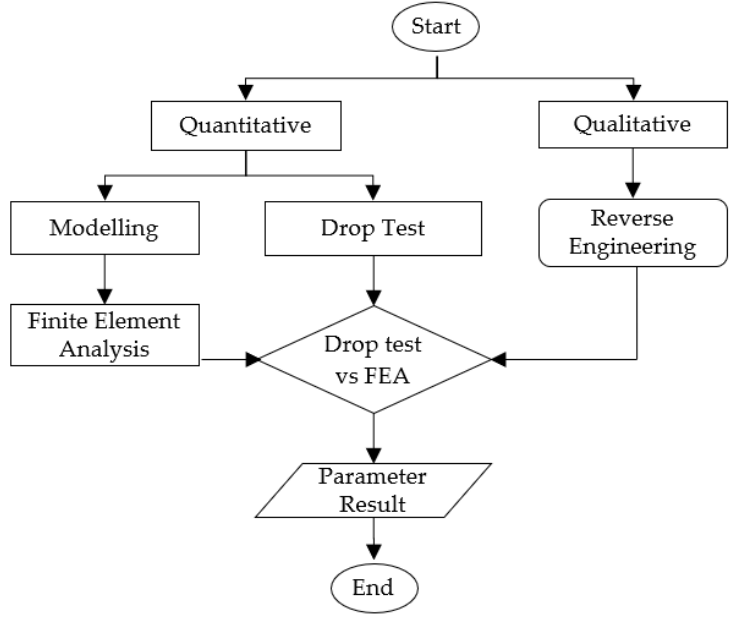
Figure 1. Flowchart of design and development